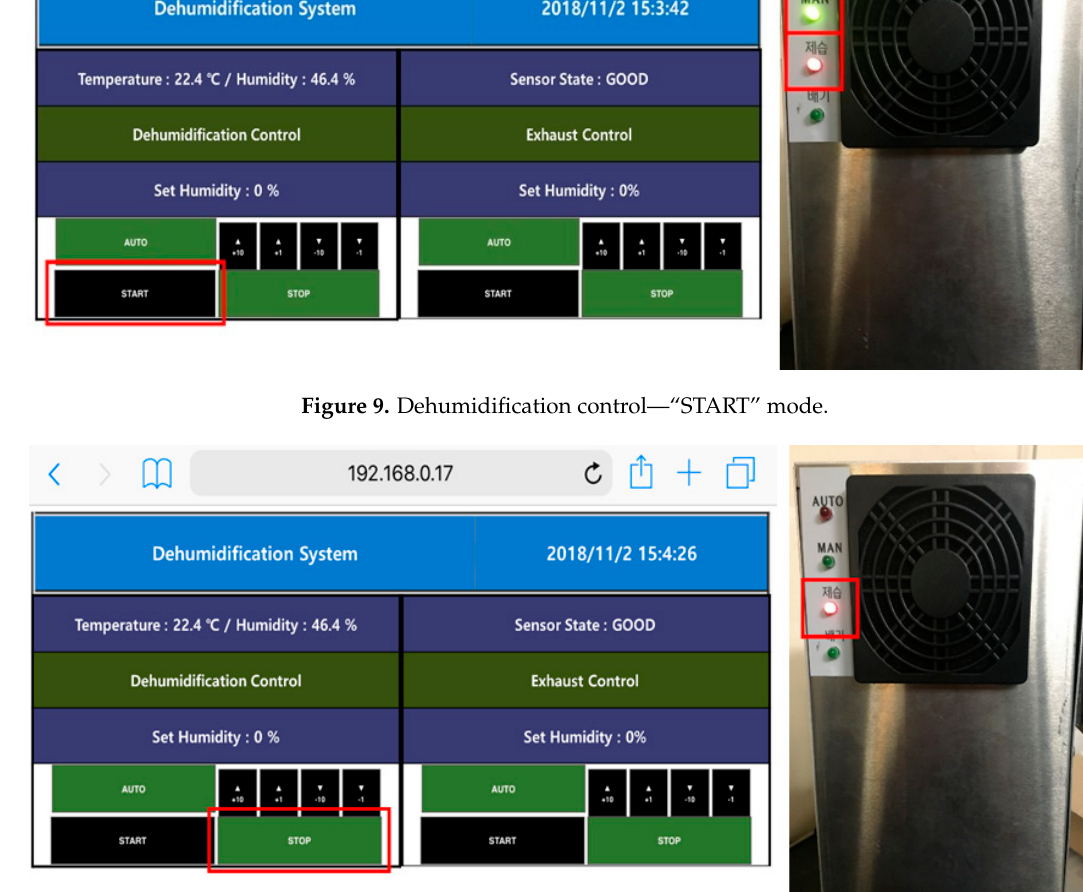
Figure 10. Dehumidification control—“STOP” mode.